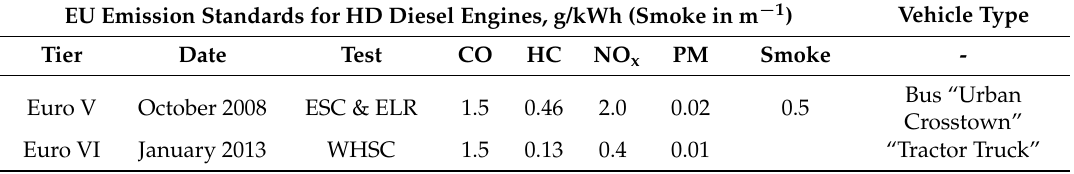
Table 1. European Union (EU) Emission Standards for HD Diesel